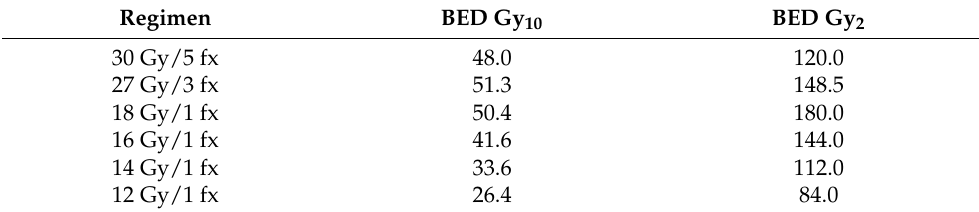
Table 2. Commonly employed SRS and HSRT schemes and their associated BED for early and late responding tissues. BED Gy 10 represents the BED for early responding tissue such as tumor cells. BED Gy 2 represents the BED for late responding tissue, such as healthy brain cells. Gy = Gray, fx =